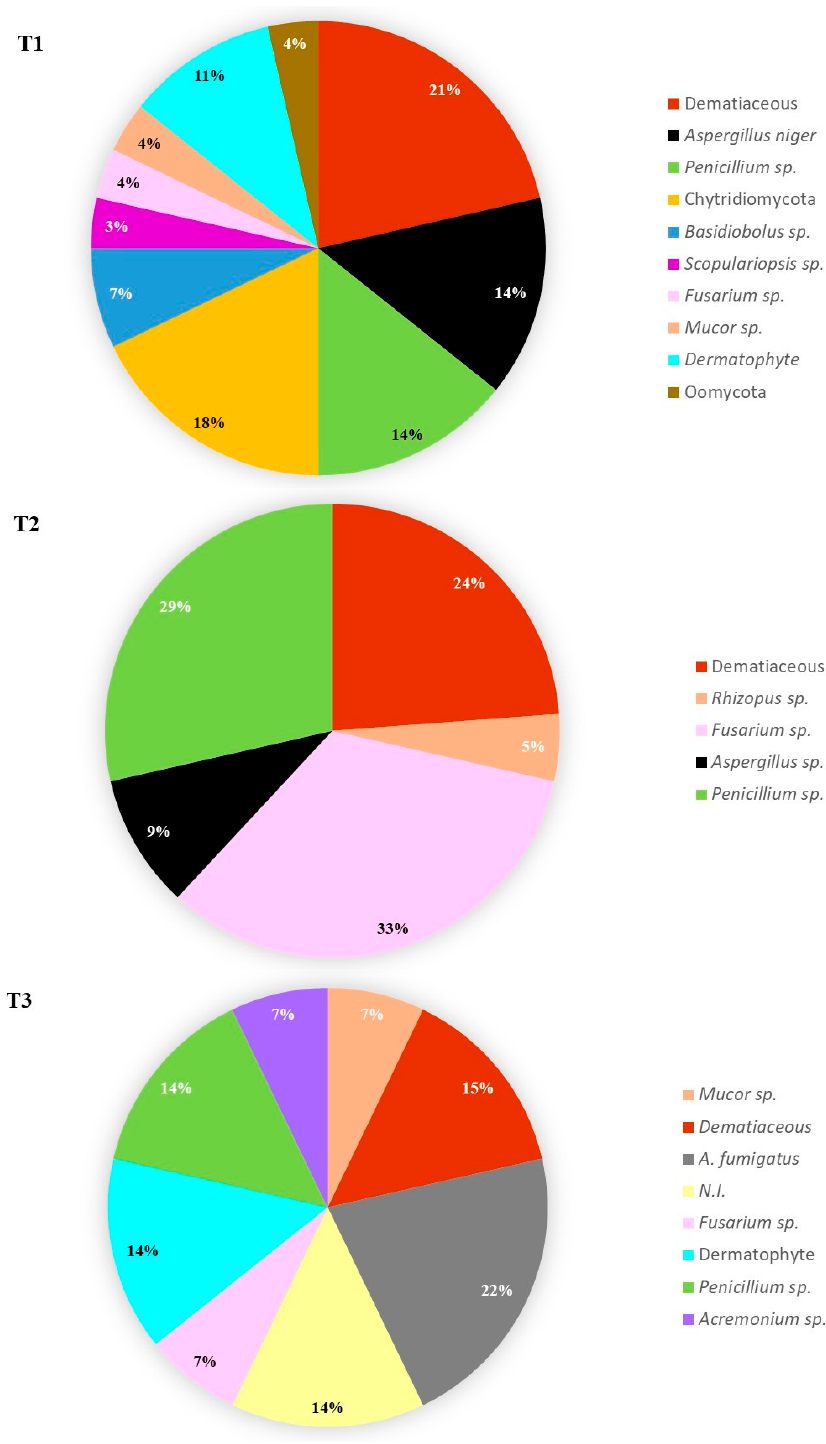
Figure 2. Fungal taxa frequency (%) in tanks (T) 1, 2 and 3. N.I.—Not identified.